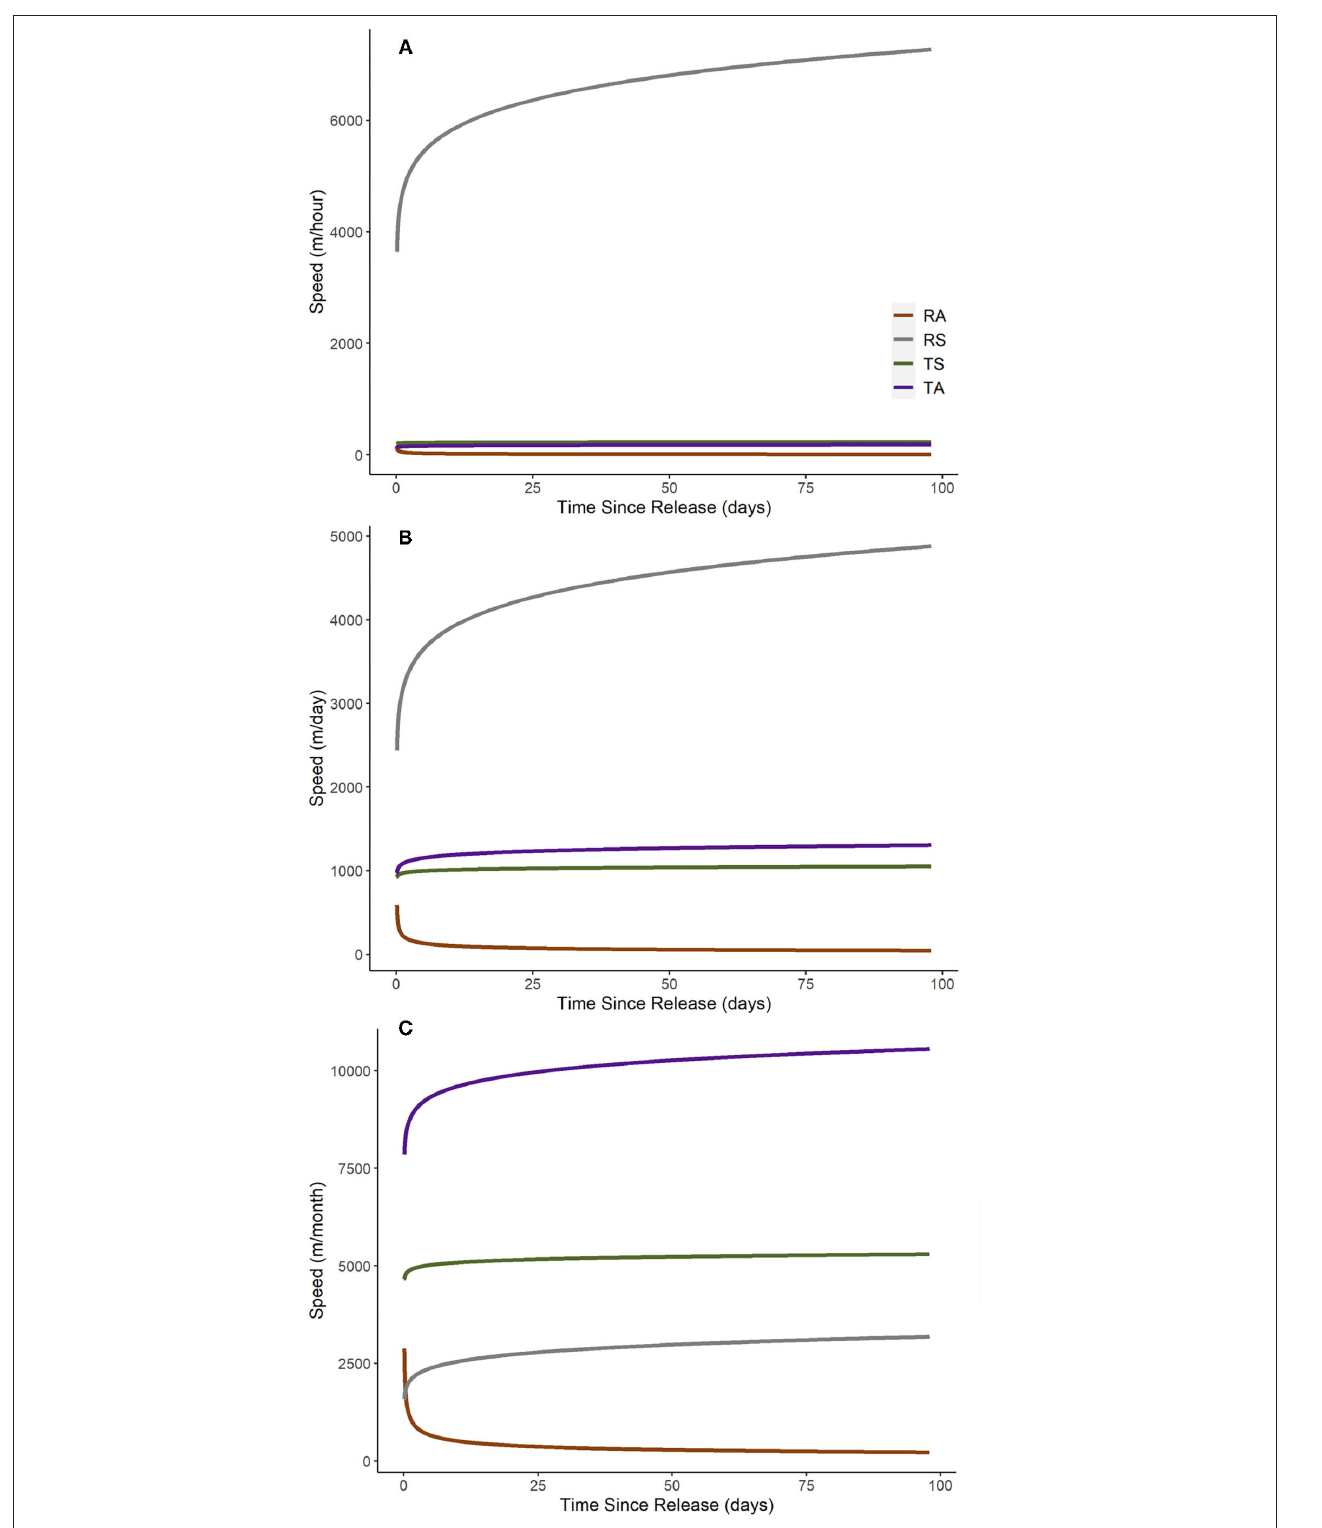
FIGURE 5 | Predicted relationship between speed (step length/step duration) at multiple temporal scales [ (A) , m/hour; (B) , m/day; (C) , m/month] and time since release for resident adult (RA), resident subadult (RS), translocated adult (TA), and translocated subadult (TS) beavers monitored in the Price, San Rafael, and Green Rivers, Utah, USA, from May 2019 through March 2021. Relationships are based on a log-log regression linear mixed model. All other covariates included in this model were held constant for visualization purposes (medium river discharge category only, PIA detections only, and mean NDVI value).